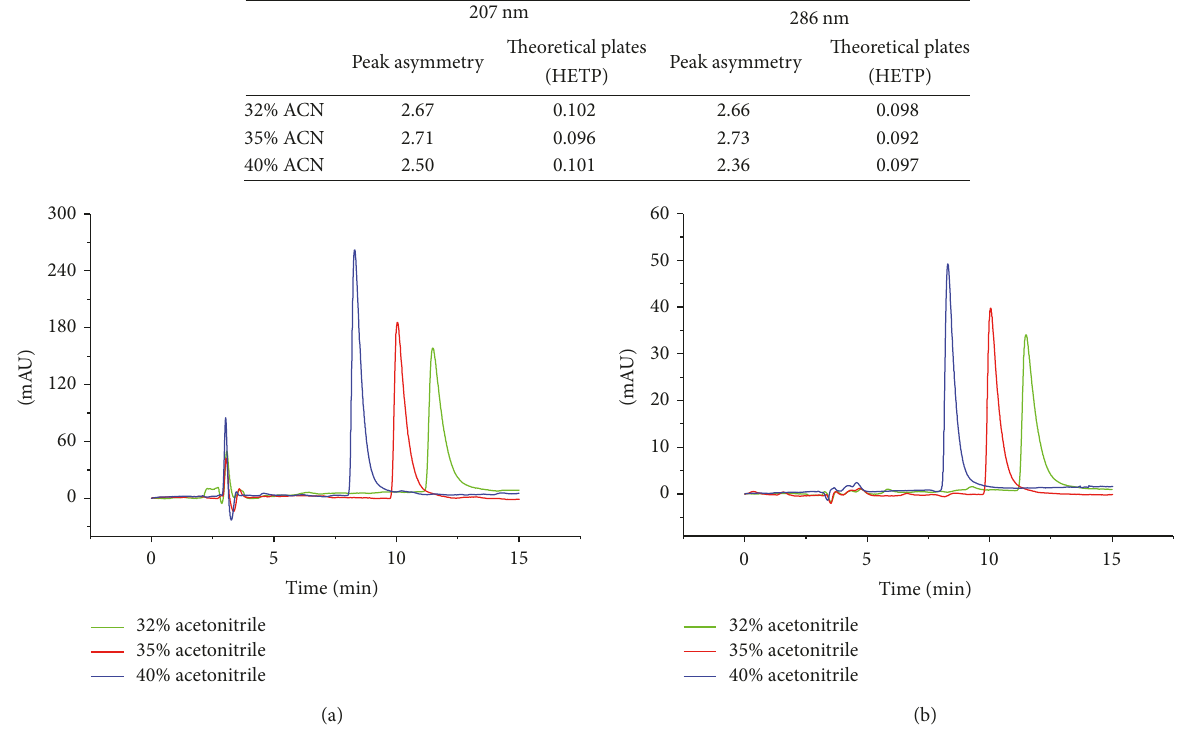
Figure 2: Optimisation of the mobile phase for the Knauer C8 column for 207 nm and 286 nm, with information about peak asymmetry and height equivalent to a theoretical plate, for various amounts of acetonitrile in the mobile phase. Table 3: Validation parameters of proposed